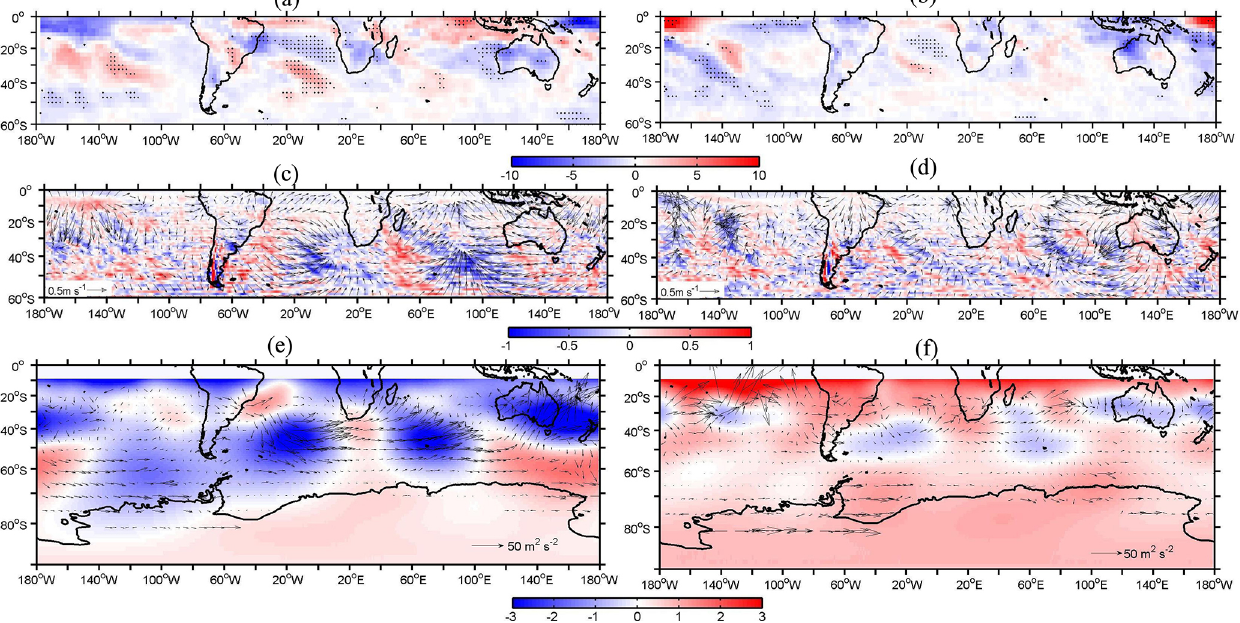
vective activities are enhanced over the southern